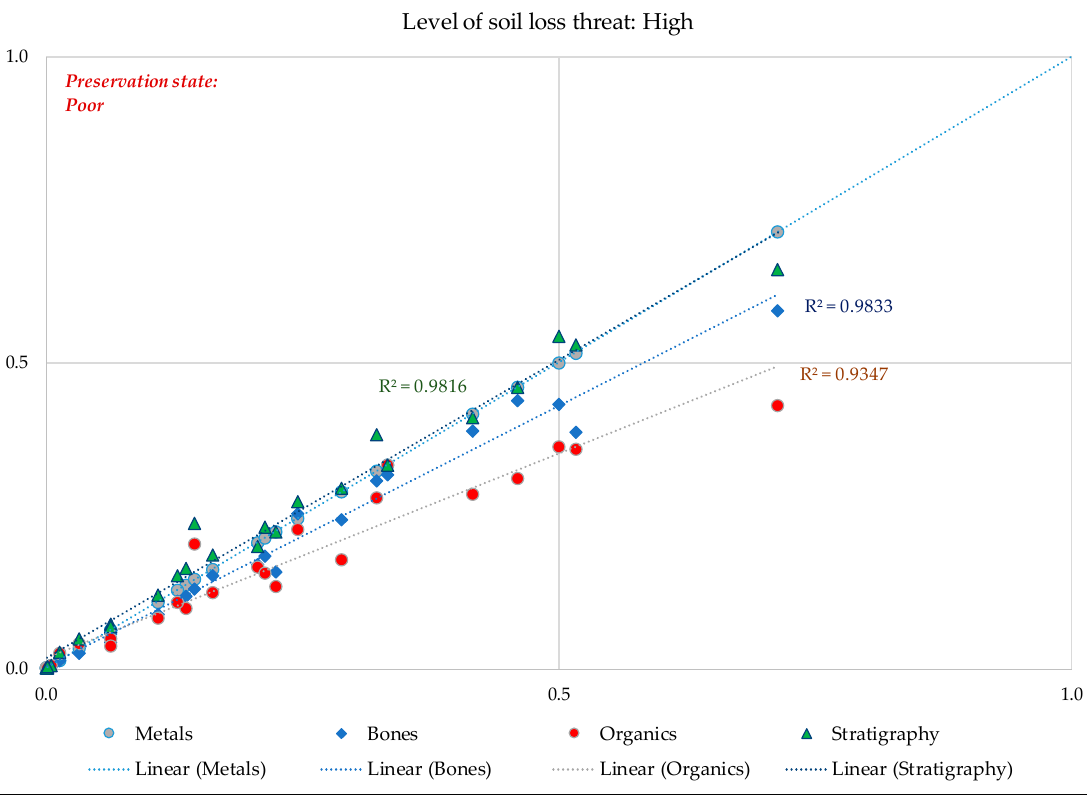
Figure 13. Correlation of the different types of subsurface objects (metals, bones, organics, and stratigraphy) between areas characterized as moderate for soil-loss threat: Metals objects were used as the baseline (R = 1). Preservation state is also indicated for areas with different colours (same as Figure 11. Note here that only poor preservation state is shown).